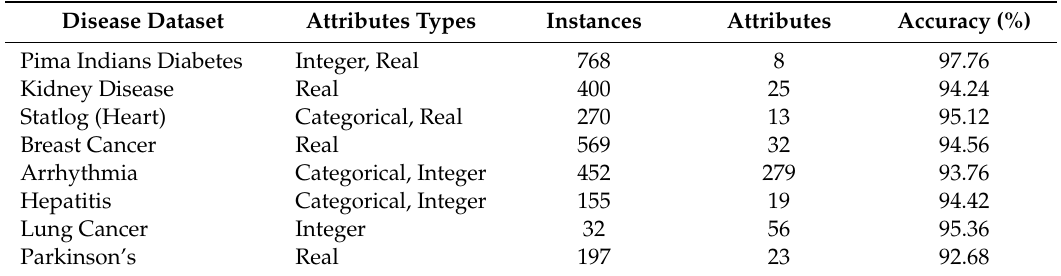
Table 23. Performance analysis of EAGA-MLP model with di ff erent chronic disease datasets.